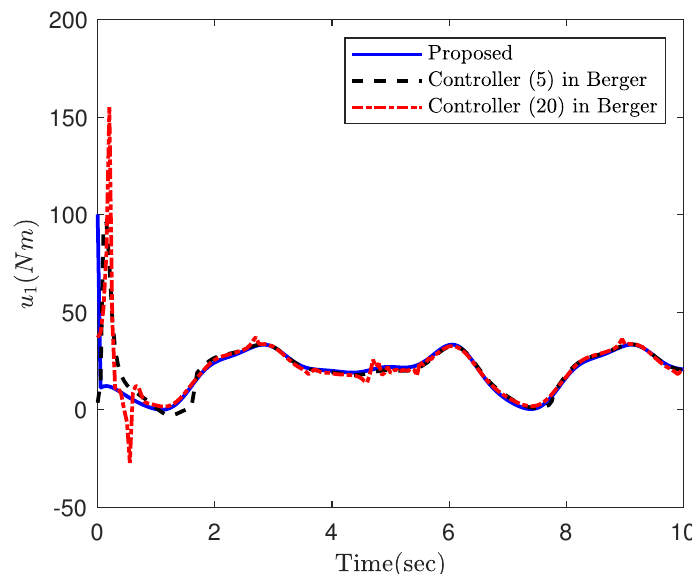
Figure 9. The first component of the control input in Part 2.